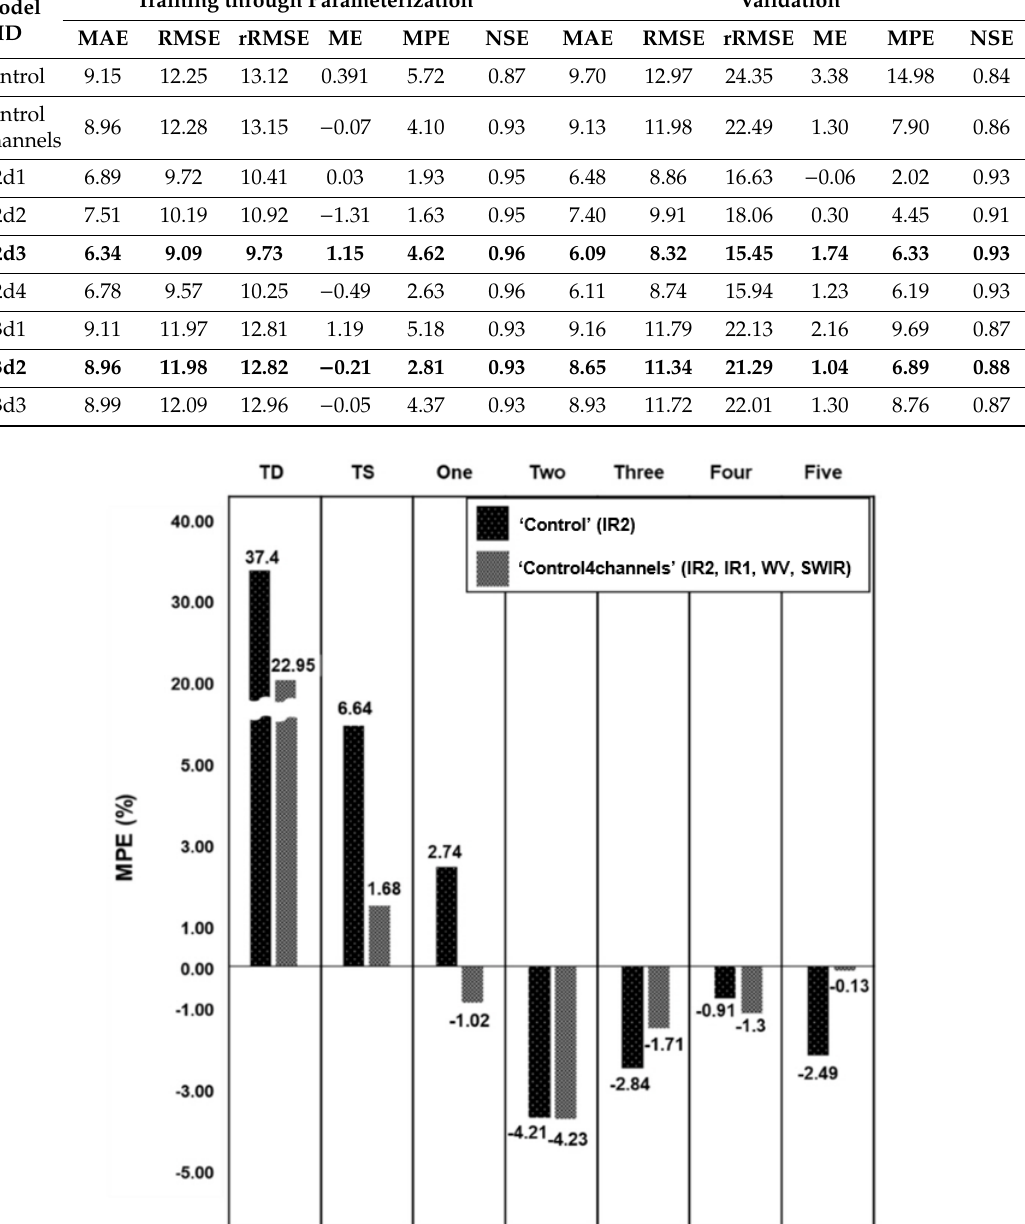
Figure 6. Mean percentage error (MPE) of 'Control' and 'Control4channels' on the Saffir – Simpson scale. Both models have the same CNN architecture except for input data. The ‘Control’ model overestimated the weak TCs whereas underestimating the strong TCs. ‘Control4channels’ model showed relatively stable performance when estimating TC intensity by scale.